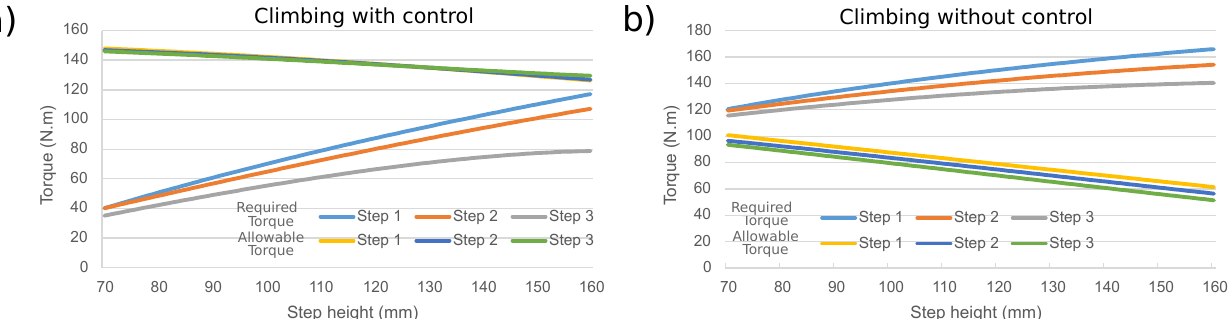
Figure 10. Change in allowable and required torque on the front wheels to overcome a step with respect to the change in height of the step while ( a ) climbing with control and ( b ) climbing without